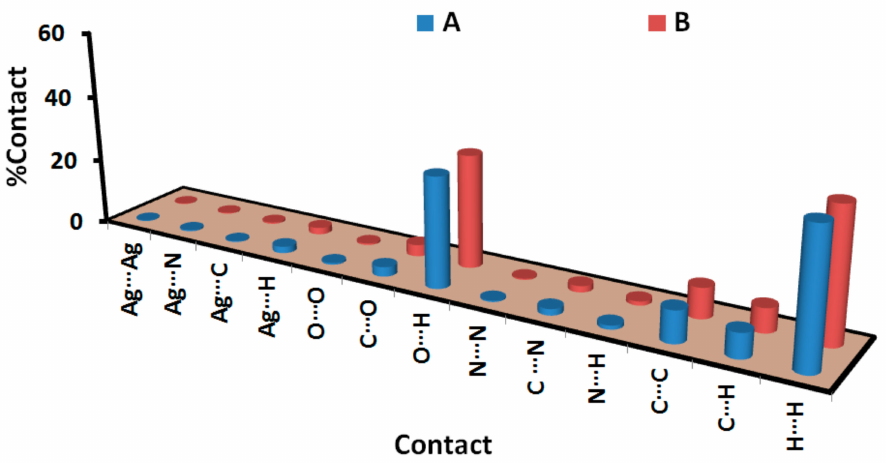
Figure 5. Distribution of the intermolecular interactions in the [Ag(Et3qu) 2 (citrate)] complex. A and B refer to the disorded parts of the [Ag(Et3qu) 2 (citrate)] complex.